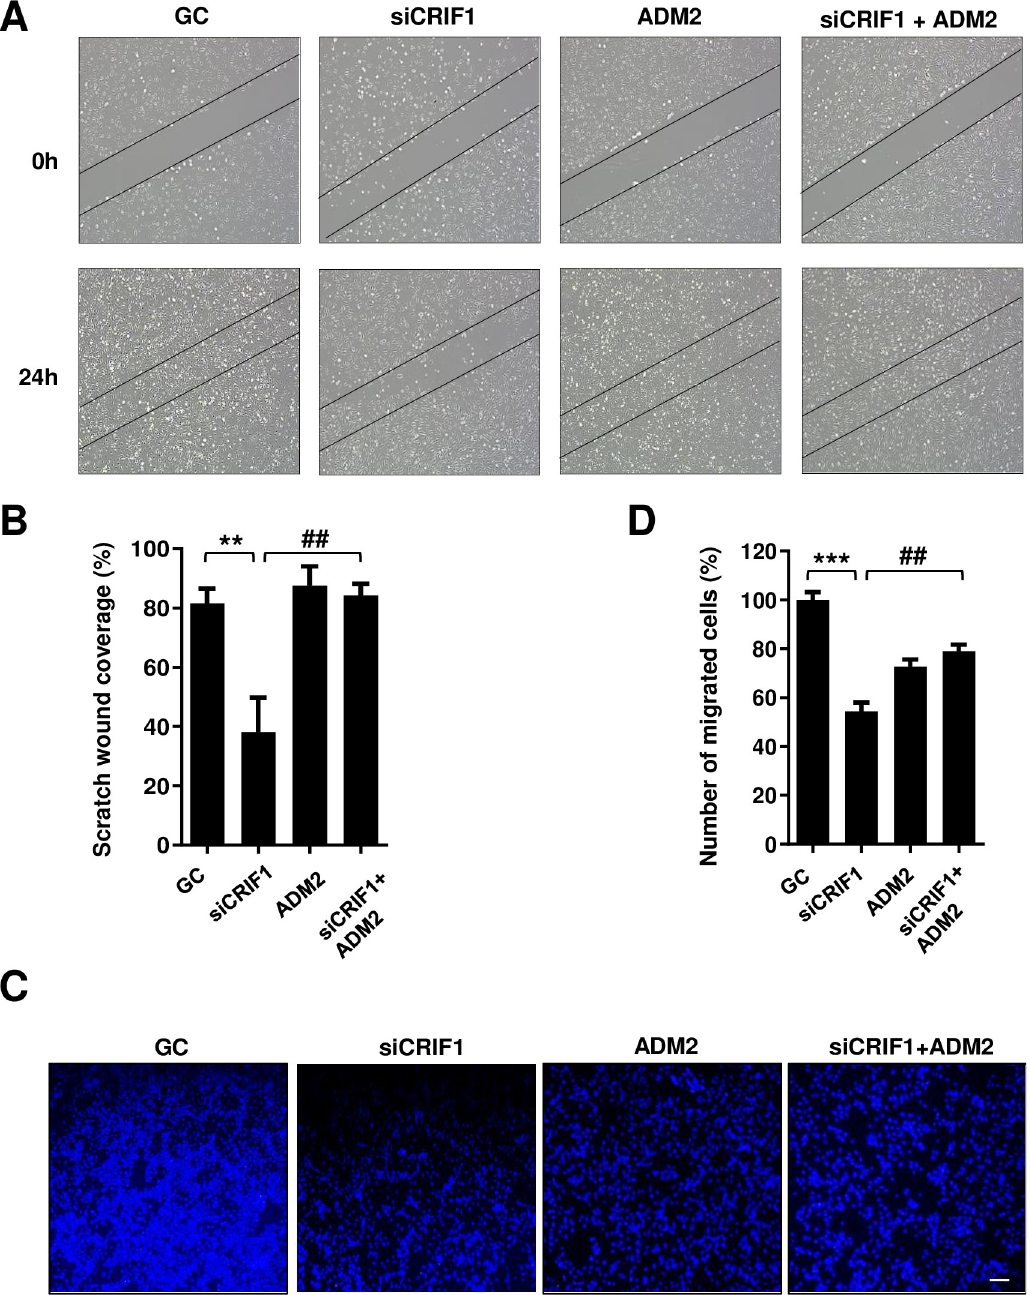
Fig 5. Effect of exogenous ADM2 on the migration of CRIF1-silenced endothelial cells. (A) HUVECs were transfected with control or CRIF1 siRNA (100 pmol) and treated with ADM2 for 24 h. Next, the cells were wounded for another 24 h. Images were obtained using a light microscope. (B) Quantification of wound closure was performed using ImageJ software. (C) HUVECs were transfected with control or CRIF1 siRNA (100 pmol), treated with ADM2 for 24 h.and transwell assay was conducted to determine cell migration. Scale bar 200 μ m. (D) Quantification of the number of migrated cells was performed using ImageJ software. Data are means ± SD of three independent experiments. �� P < 0.01 and ��� P < 0.001 relative to the control, ## P < 0.01 relative to siCRIF1 (n = 3 per